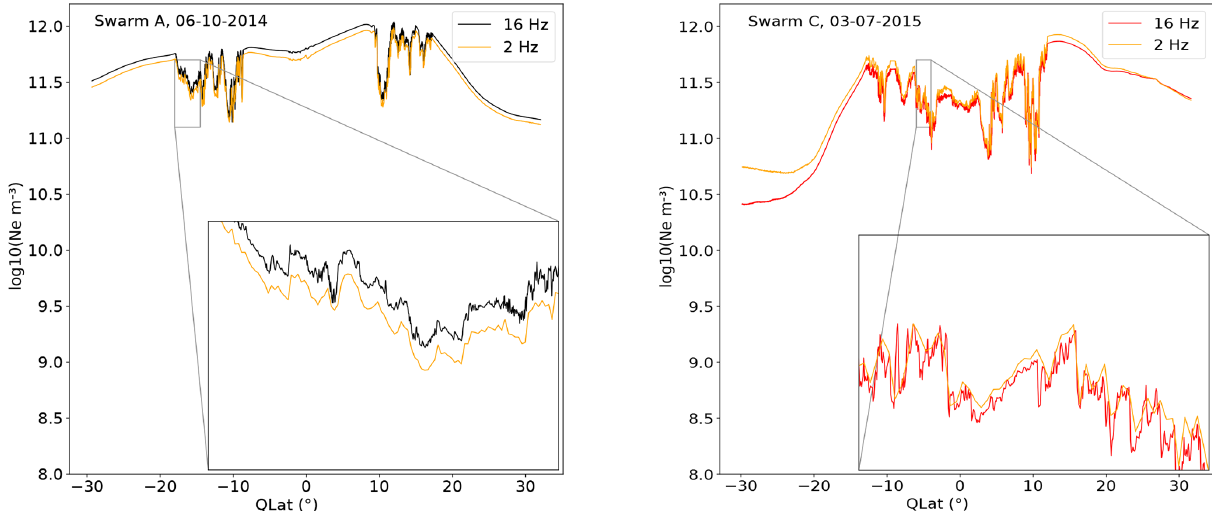
Figure 1. Comparison of 2Hz LP data and 16Hz faceplate data for Swarm A and C on 6 October 2014 and 3 July 2015, respectively.